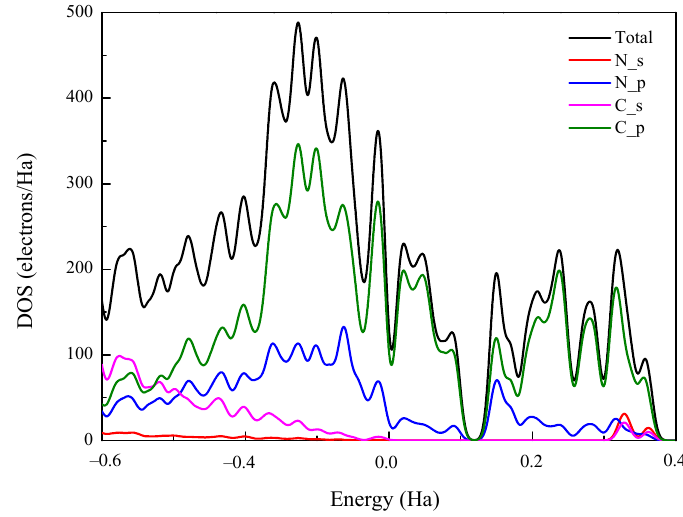
Figure 3. The density of state analyses of the N-MGN structures.